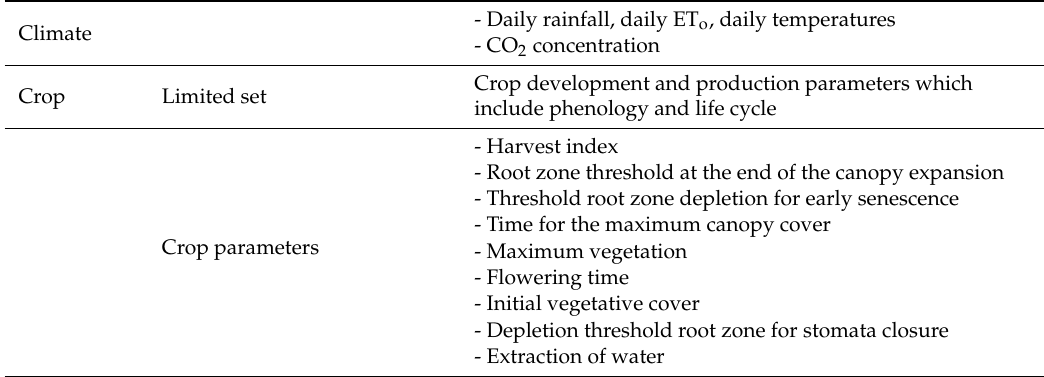
Table 3. Climate, soil and crop parameters used for the simulation model